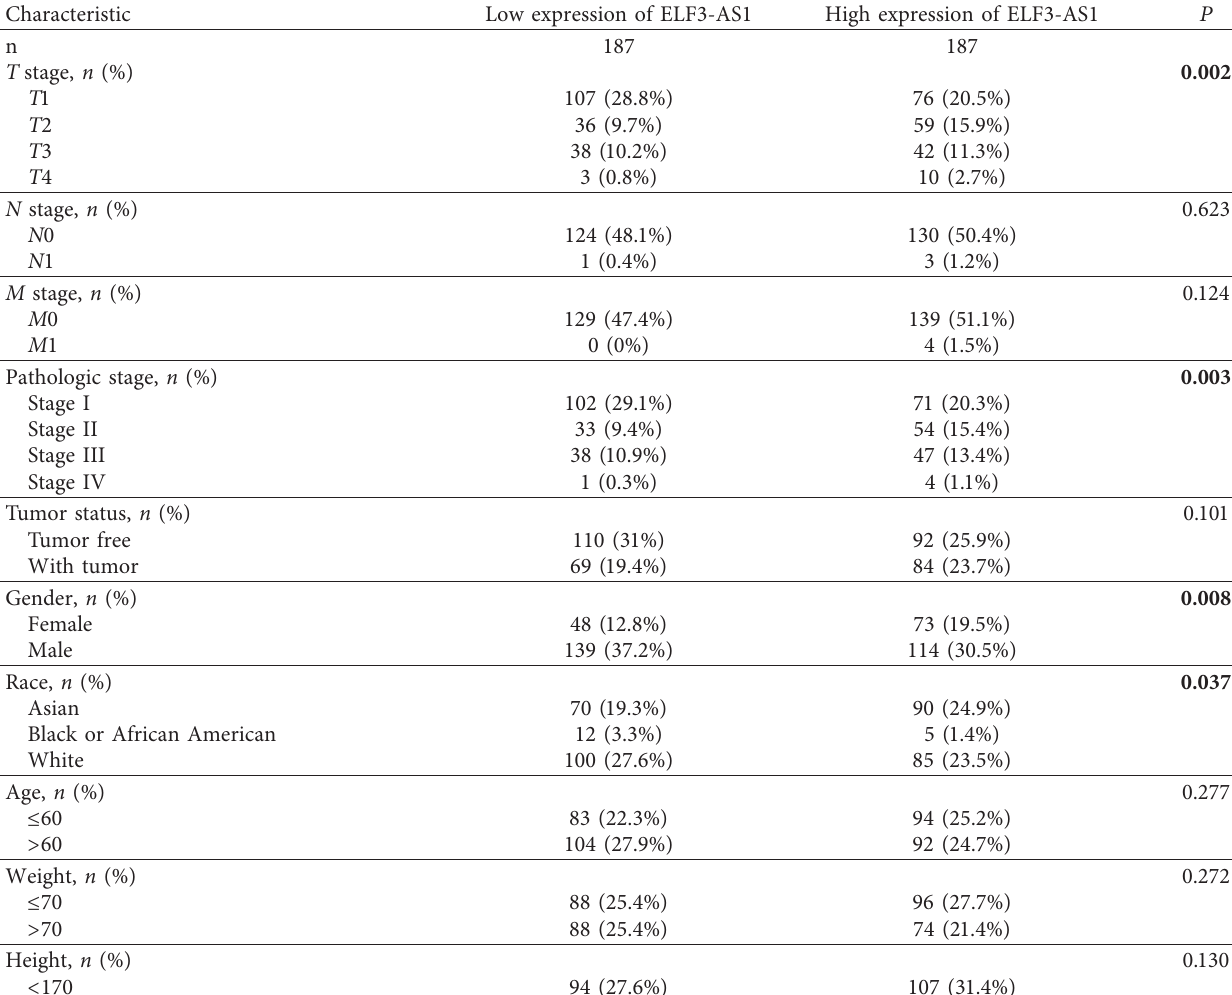
Table 2: Correlation between ELF3-AS1 expression and clinical characteristics of HCC.